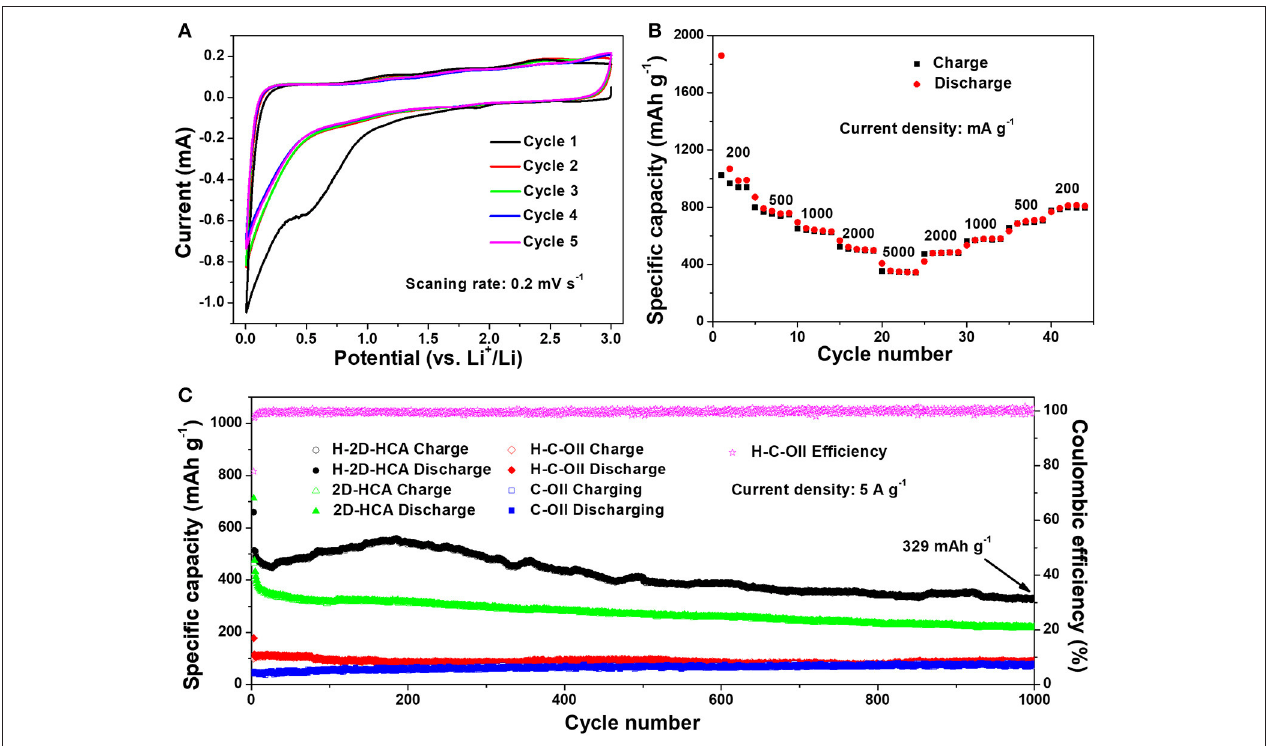
FIGURE 4 | CV curves of H-2D-HCA for the first five cycles, and the canning rate is 0.2mV s − 1 ; (B) Rate performance of H-2D-HCA at different current densities; (C) Long-term cycling performance of H-2D-HCA, 2D-HCA, H-C-OII, and C-OII at a current density of 5A g − 1 along with the corresponding coulombic efficiency of